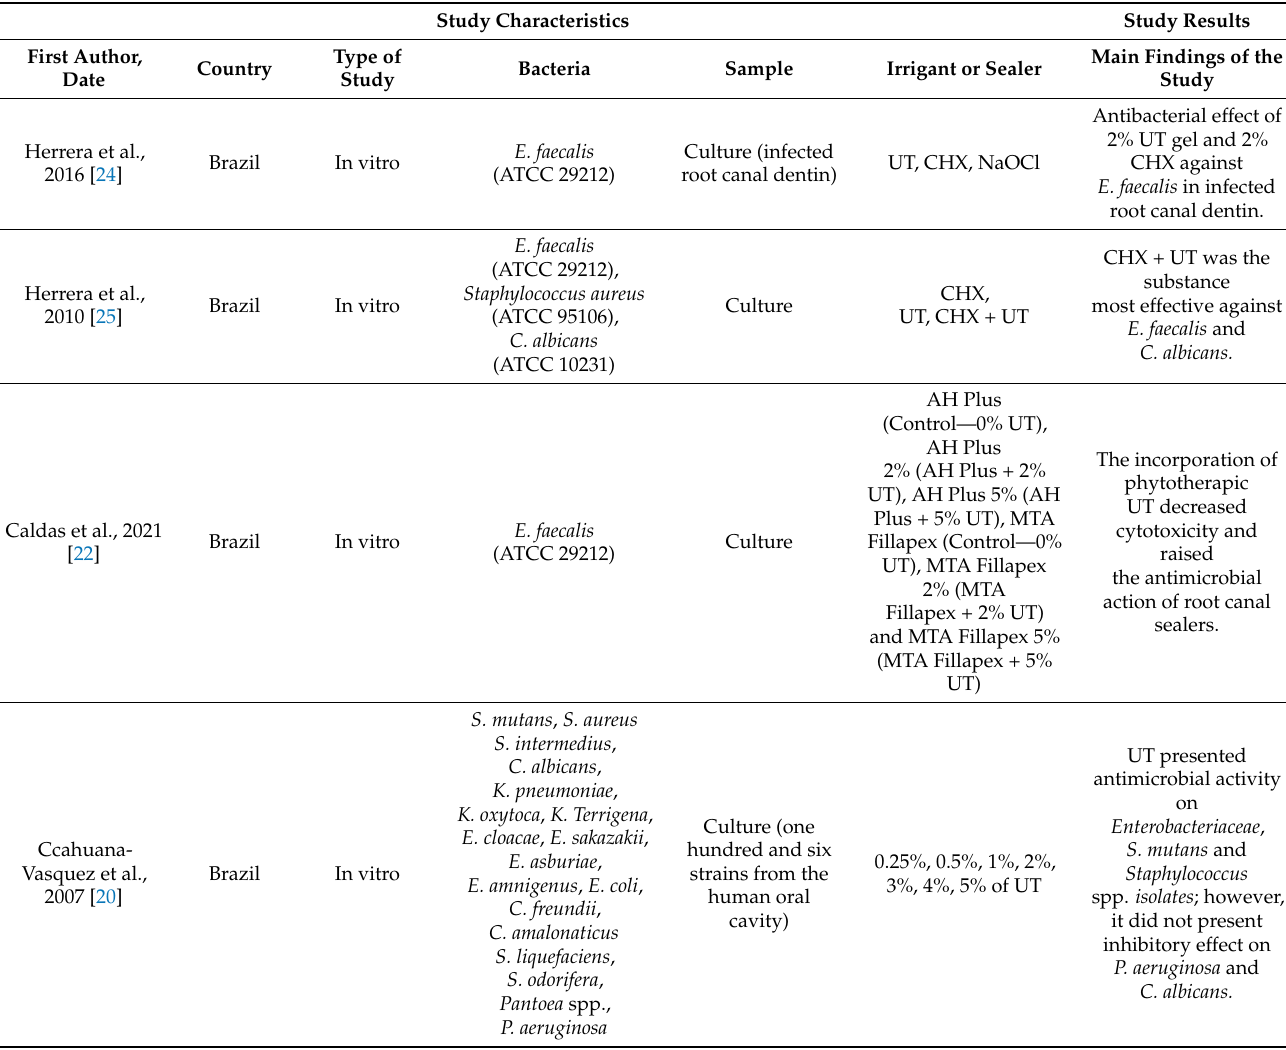
Table 1. In vitro microbiological studies, UT ( Uncaria tomentosa ).